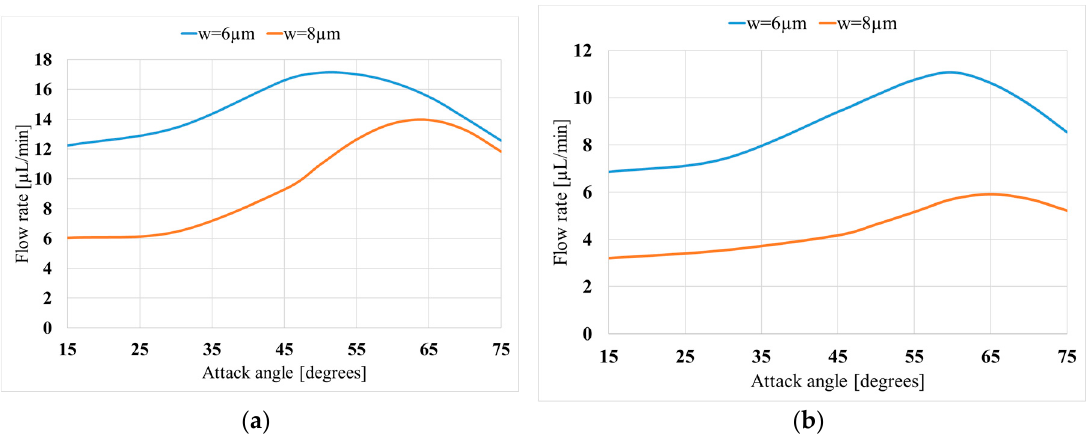
Figure 10. Variation of the obtained flow rate with valve attack angle ( θ ) for two valve widths (w); ( L p = 5mm, V = 400 V); ( a ) inlet valve; ( b ) outlet valve.